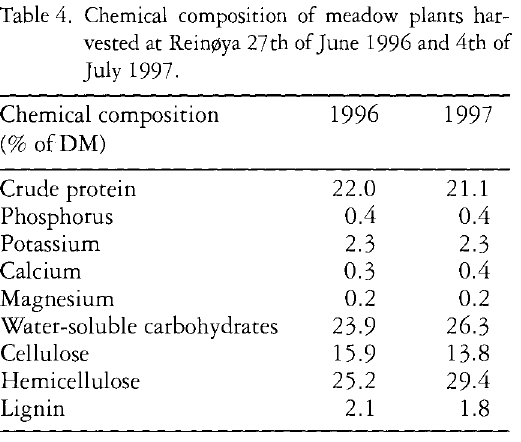
Table 4. Chemical composition of meadow plants har vested at Reinøya 27th of June 1996 and 4th of